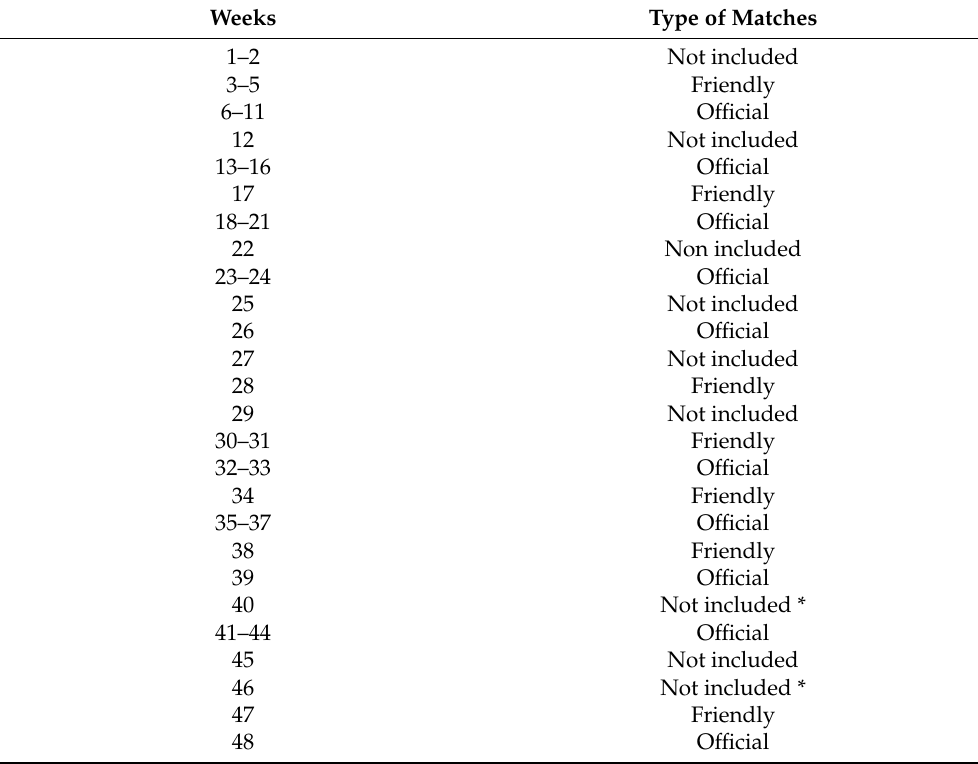
Table 1. Characterization of the weeks and matches included for